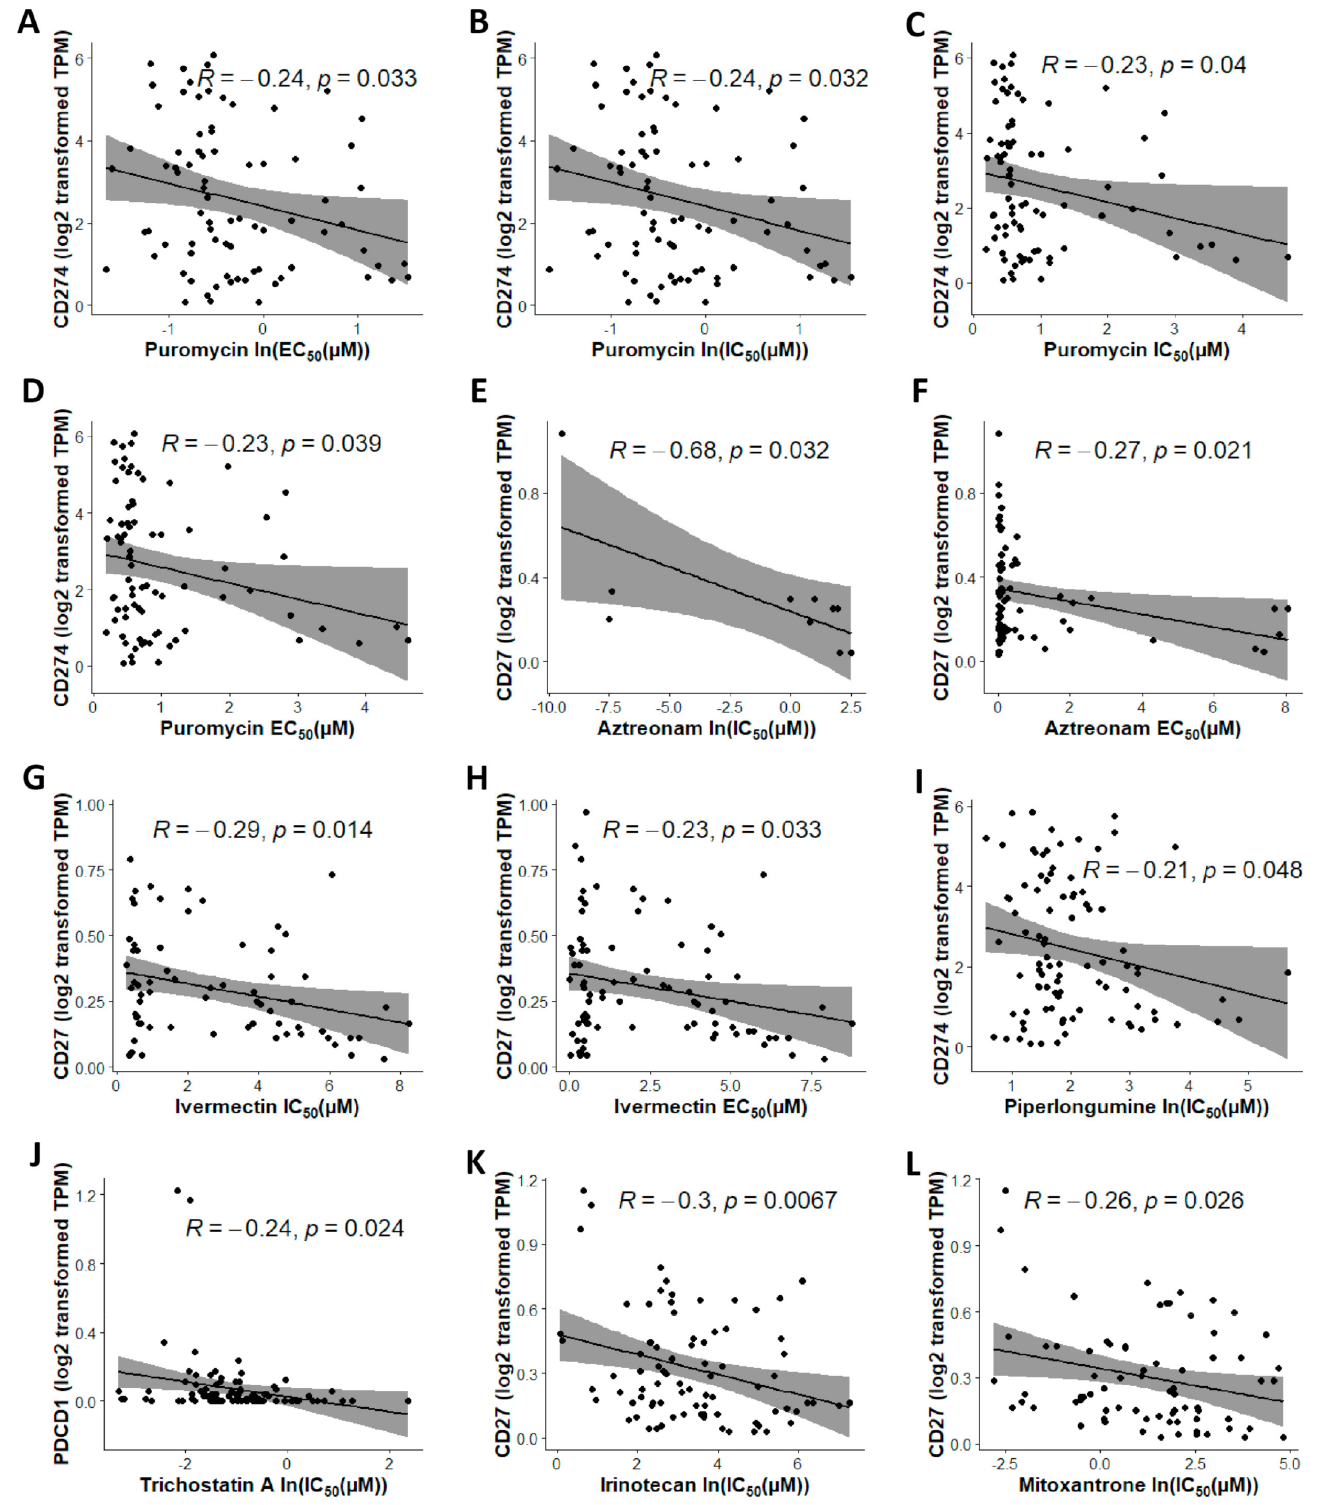
Figure 7. Compounds with a significantly negative correlation of drug concentration and the mRNA expression of CD27 , PD1 , or PDL1 in the CCLE NSCLC cell lines ( n = 117). The drug activity measurements included IC 50 , EC 50 , ln(IC 50 ), and ln(EC 50